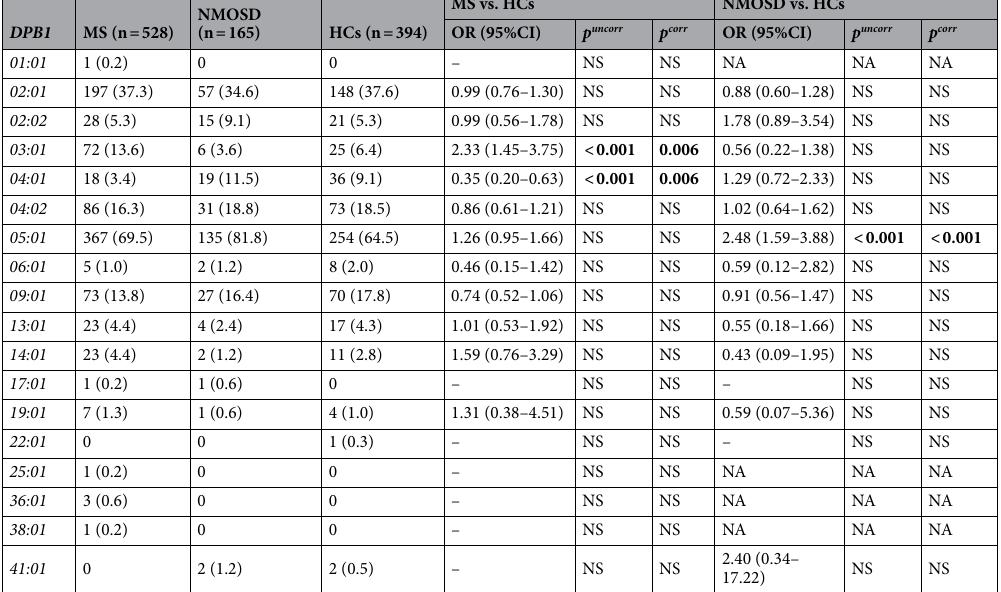
Table 3. Carrier frequencies of HLA-DPB1 in patients with MS and NMOSD and in healthy controls. Bold values indicate significant differences. Values are numbers (%). CI confidence interval, HC healthy control, MS multiple sclerosis, NA not applicable, NS not significant, OR odds ratio, p corr corrected p value, p uncorr uncorrected p value.